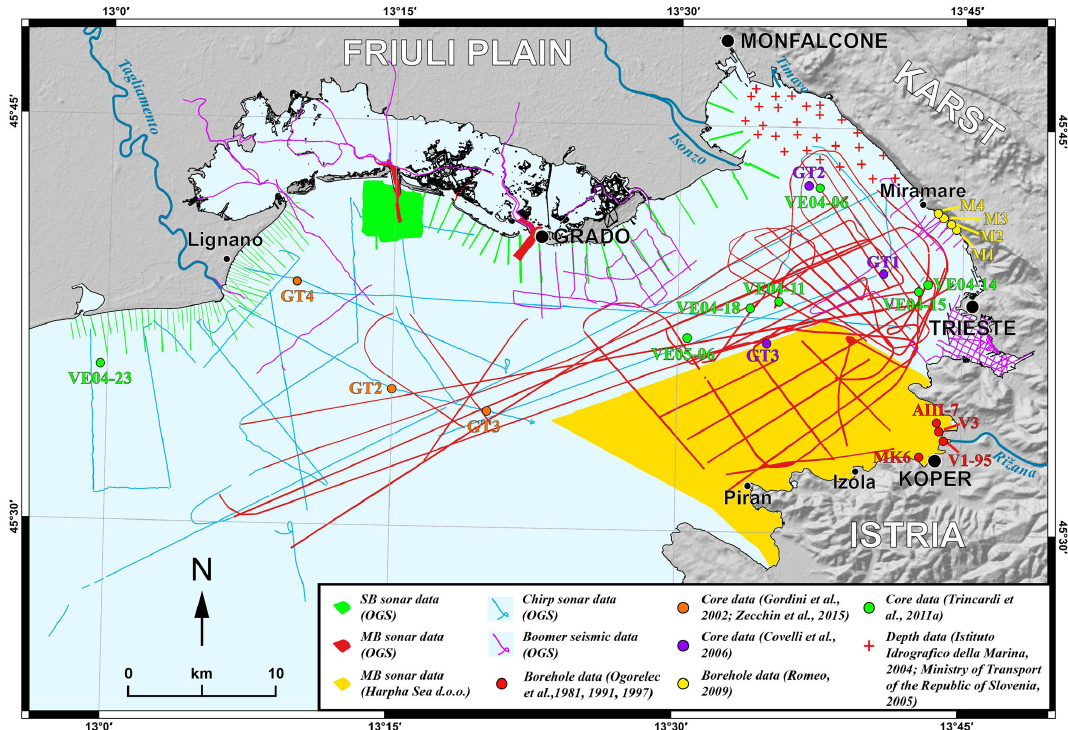
Figure 4. Locations of the datasets used for the bathymetric model of the Gulf of